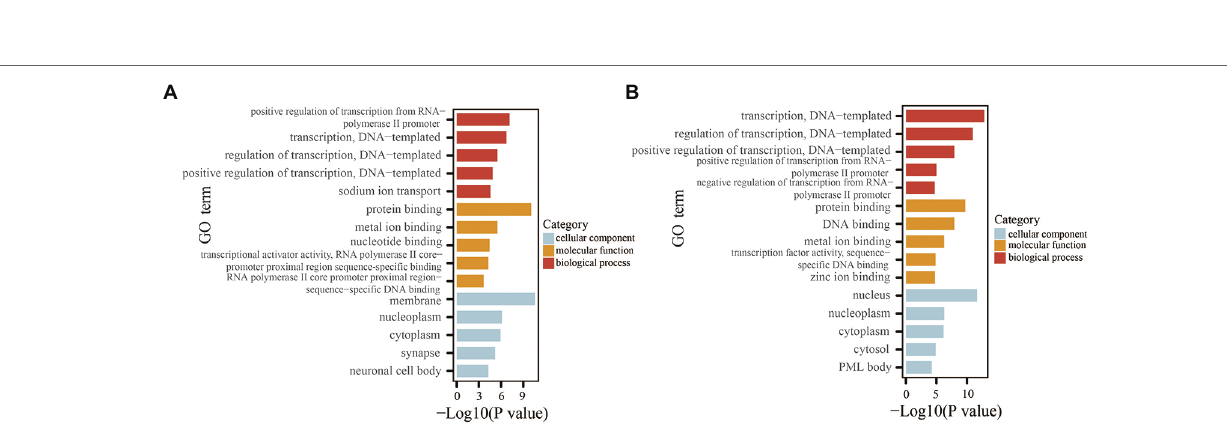
FIGURE 7 | GO analysis of the miRNAs based on the predicted target genes. (A) Top five significant GO terms of each category for the downregulated miRNAs. (B) Top five significant GO terms of each category for the upregulated miRNA. GO, Gene Ontology.